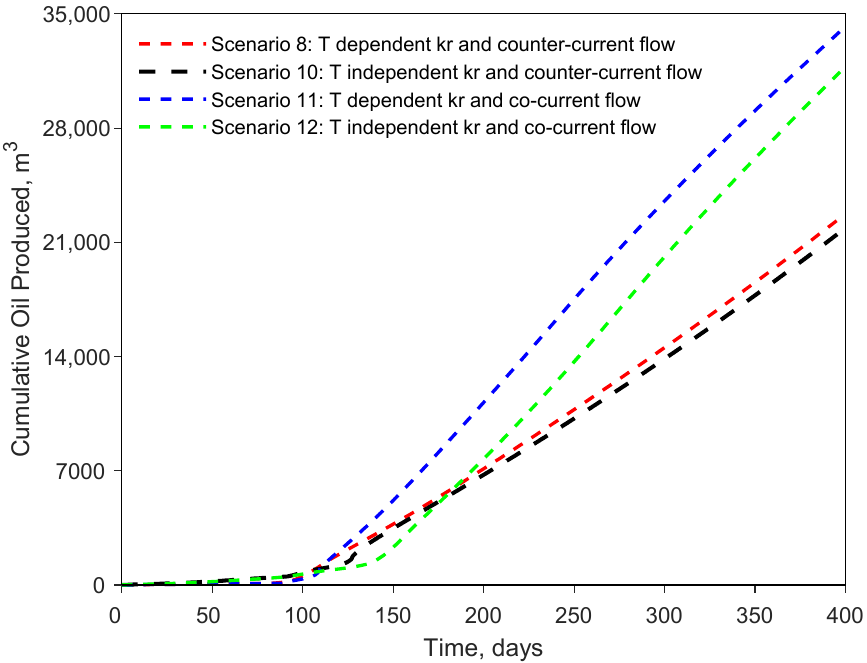
Figure 13. Cumulative oil production of scenarios 8, 10, 11 and 12 under varying relative permeability settings.